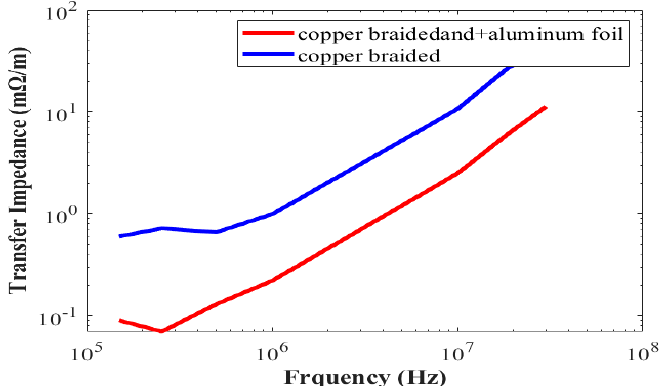
Figure 8. Impedance comparison of the two shielding modes.